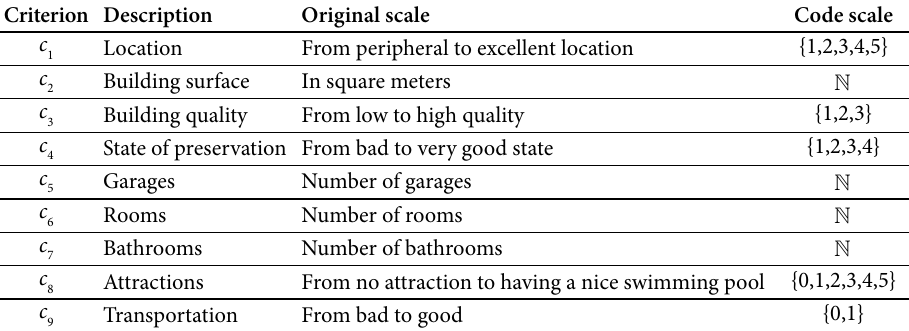
Table 1. Family of criteria